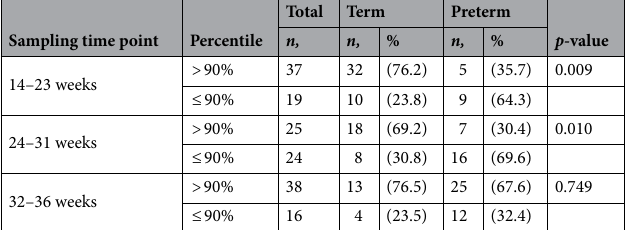
Table 5. Comparison between the frequencies of FTB and PTB according to vaginal Lactobacillus abundances (n = 159). Statistical analysis was performed by Fisher’s exact test. FTB Full-term birth, PTB Preterm birth.